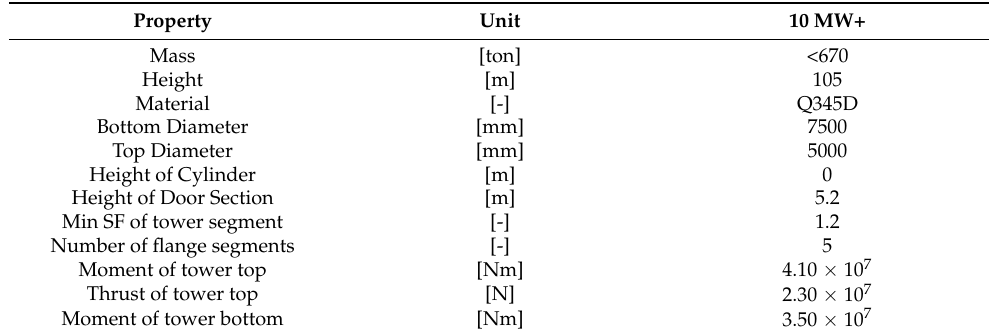
Table 4. Basic requirement of 10 MW+ offshore wind turbine tower.